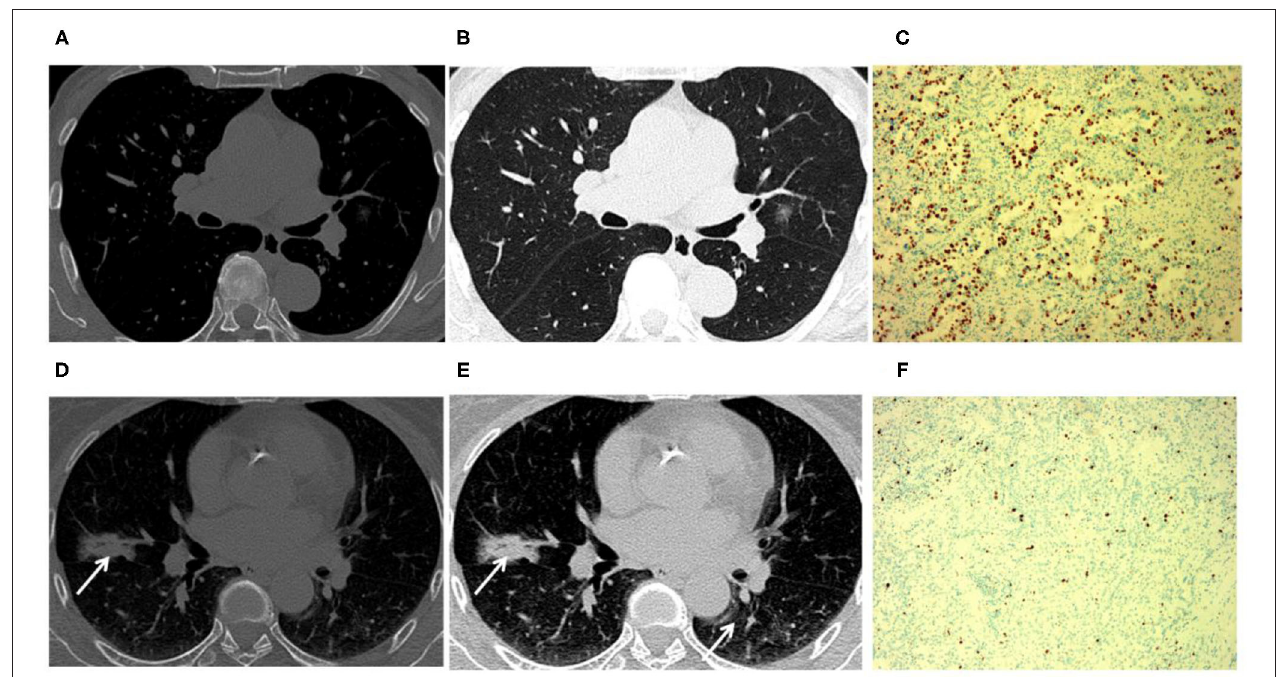
FIGURE 4 | Tumors with positive Ki-67 expression levels were more inclined to have air bronchograms than those with negative Ki-67 expression levels. An 81-year-old male patient with Ki-67 negative expression (A–C) . (A,B) CT image showed that a tumor had a negative expression of Ki-67 without an air bronchogram. (C) The Ki-67 expression was 5% in the glandular epithelium. A 63-year-old female patient with positive Ki-67 expression (D–F) . (D,E) CT image showed that a tumor had positive Ki-67 expression with an air bronchogram. (F) The Ki-67 expression was 55% in the glandular epithelium (arrow).